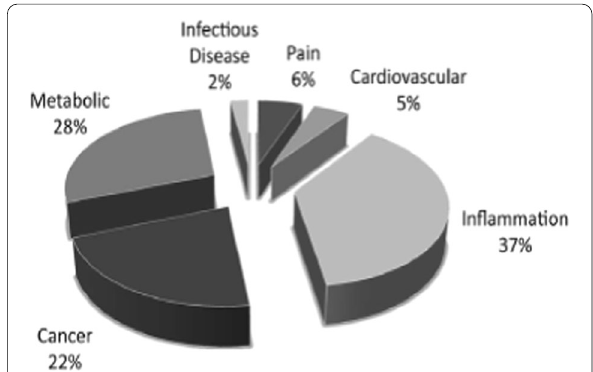
Fig. 2 Pathological conditions with GPCRs as suitable targets for therapeutic antibodies